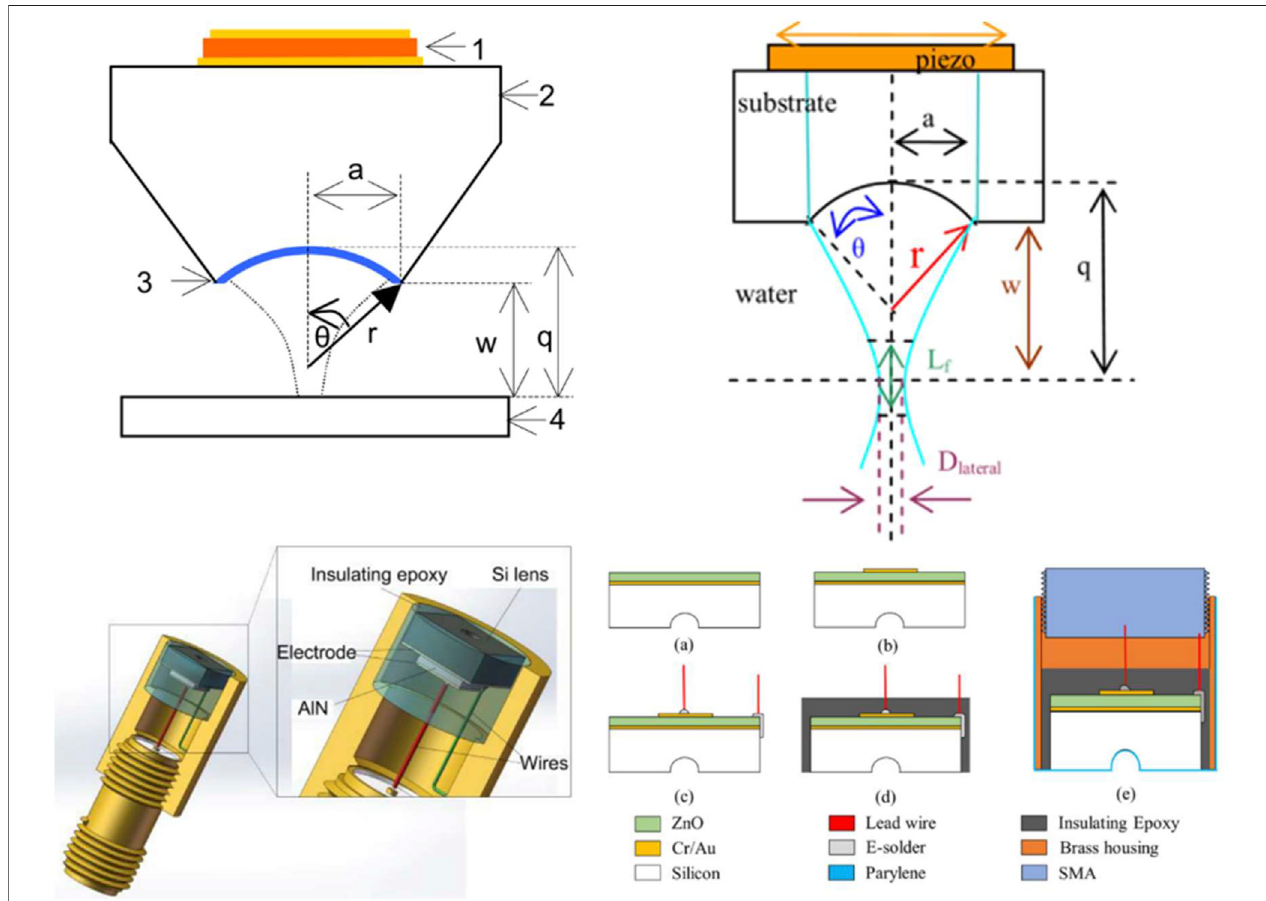
FIGURE 5 | Schematic diagram of UHF ultrasonic transducer with silicon acoustic